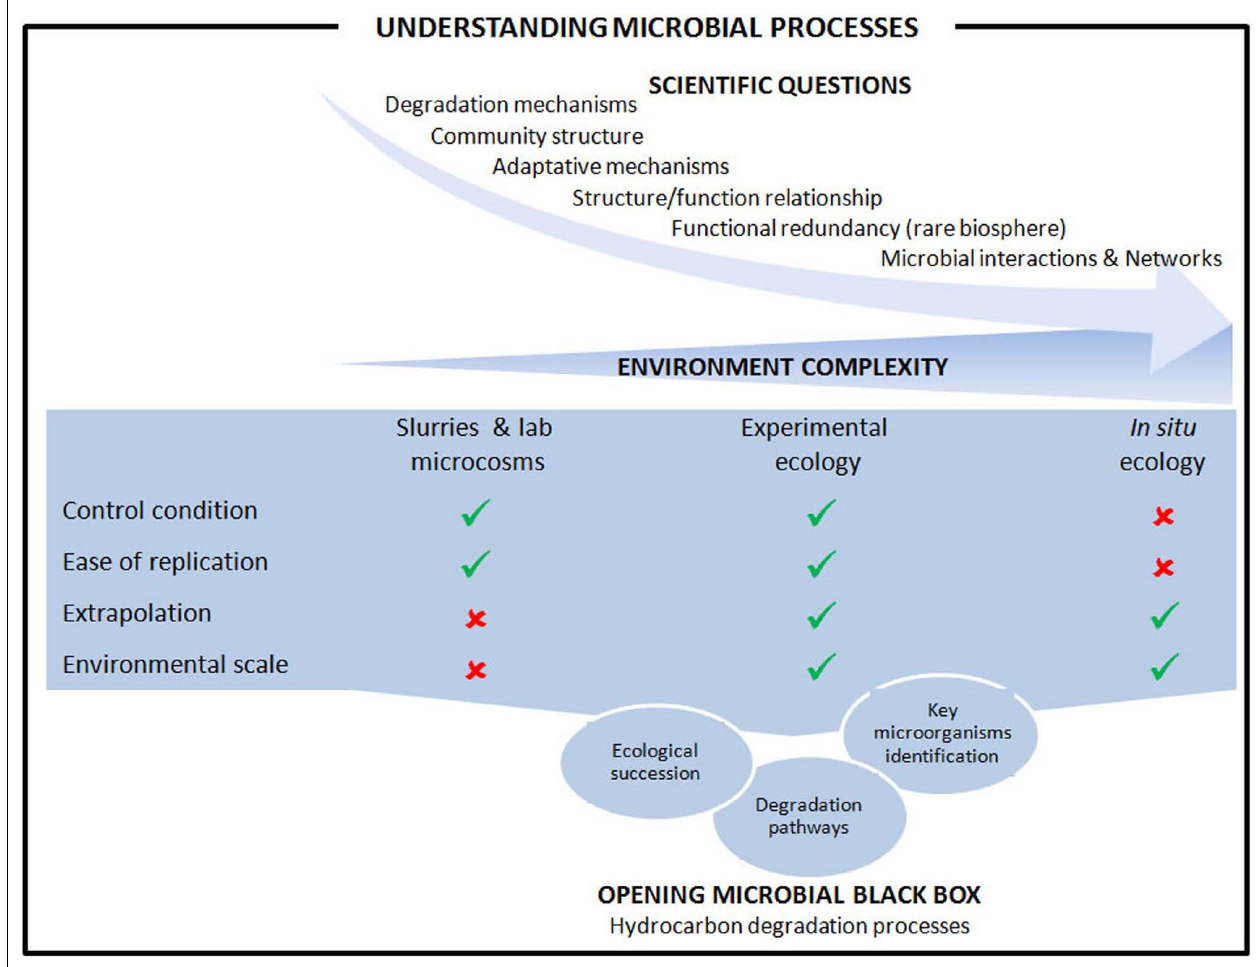
FIGURE 2 | Understanding microbial processes involved on hydrocarbon degradation in marine coastal sediments. The general scheme from scientific questions to microbial processes is presented together with the comparison of experimental approaches developed at different environmental complexity.